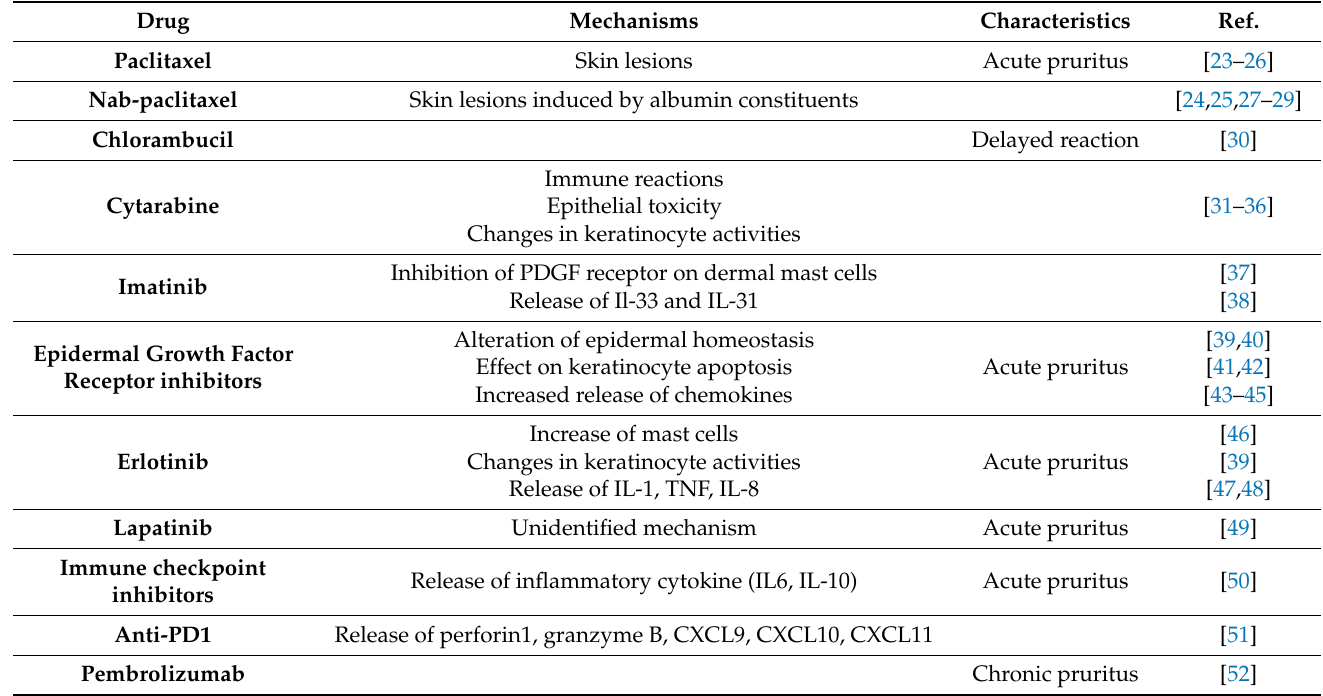
Table 1. Possible mechanisms and characteristics of antineoplastic drug-induced pruritus. Drug Mechanisms Characteristics